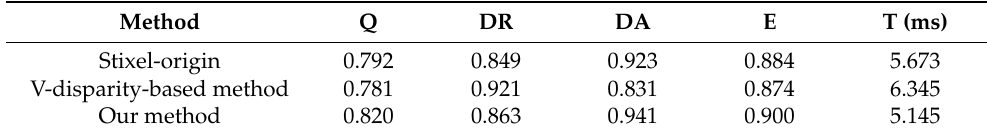
Table 3. Result of different algorithm.